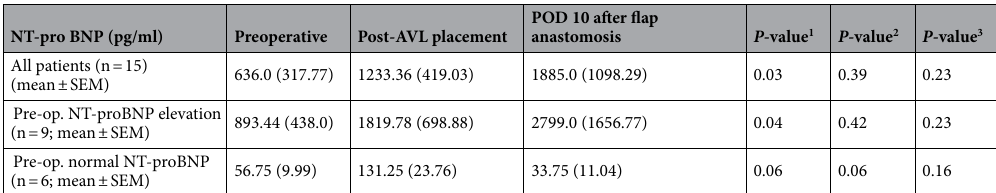
Table 3. N-terminal pro brain natriuretic peptide (NT-pro BNP) levels of the patients. AVL = arteriovenous loop, POD = postoperative day. 1 T-Test Preoperative vs. Post-AVL placement. 2 T-Test Post AVL placement vs. POD 10 after flap anastomosis. 3 T-Test Preoperative vs. POD 10 after flap anastomosis.